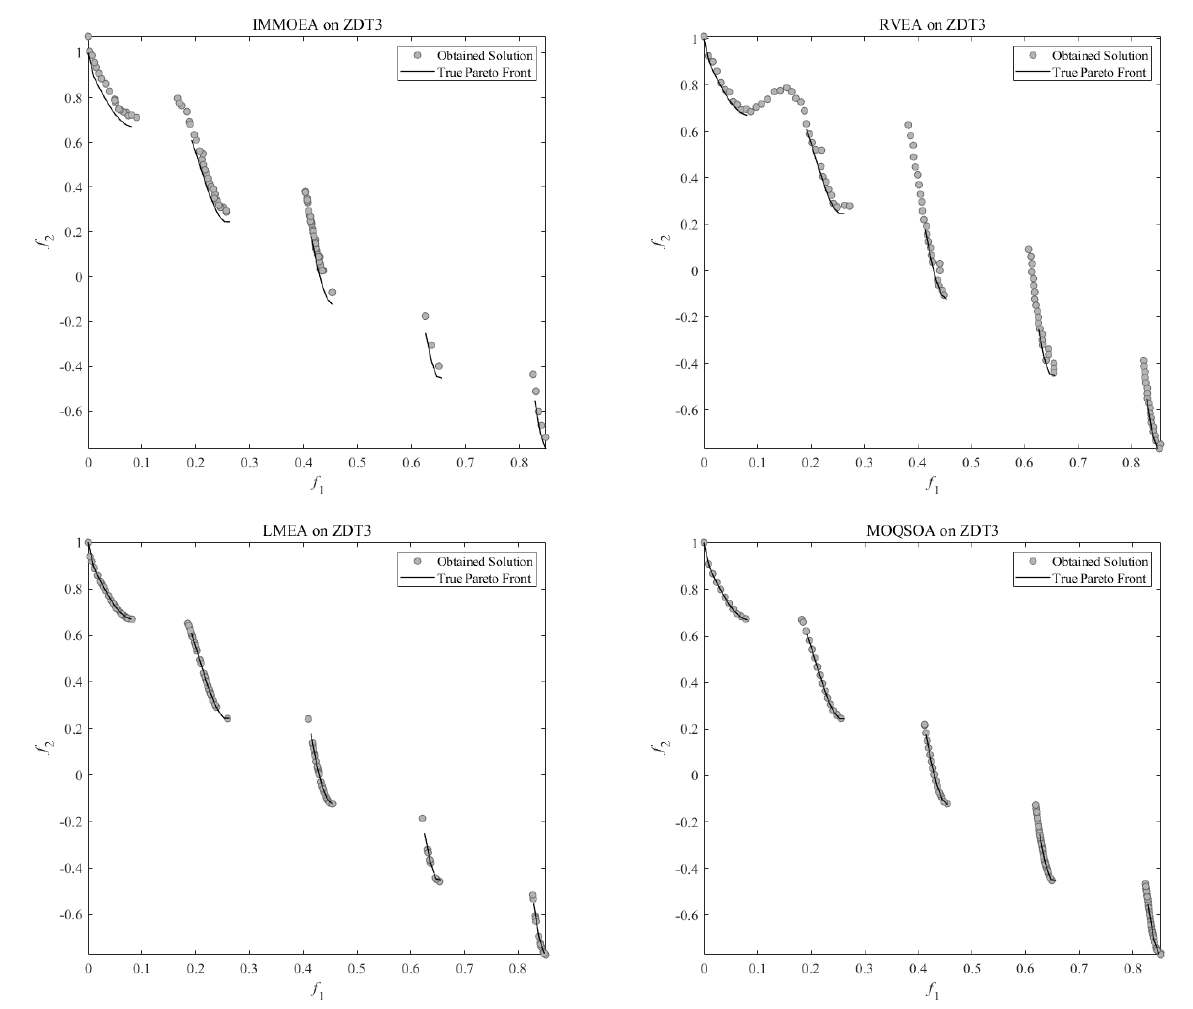
Figure 6. Pareto fronts of each algorithm for ZDT3.